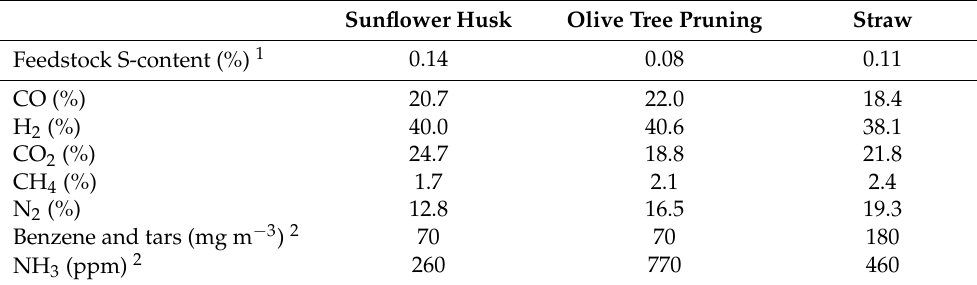
Table 2. Average GC-derived gas composition before bench-scale test rig (post-reformer). Sunflower Husk Olive Tree Pruning Straw Feedstock S-content (%) 1 0.14 0.08 0.11 CO (%) 20.7 22.0